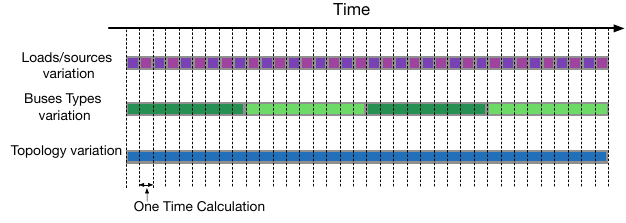
Figure 5. Power system analysis without the proposed